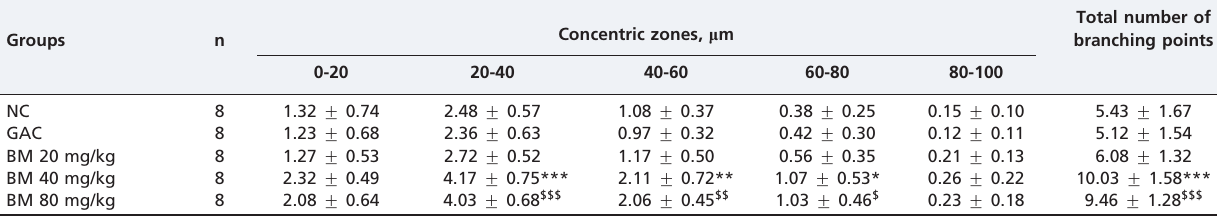
Table 2 - Basolateral amygdaloid neuronal dendritic branching points at different concentric zones and the total number of branching points (4-week duration).